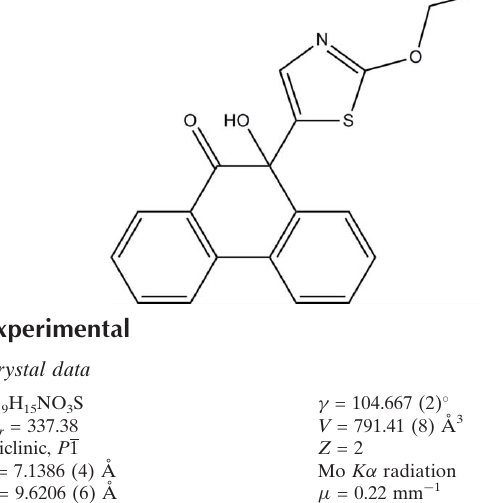
Data collection Bruker APEXII DUO CCD area- detector diffractometer Absorption correction: multi-scan ( SADABS ; Bruker, 2009) T min = 0.916, T max = 0.958 Refinement